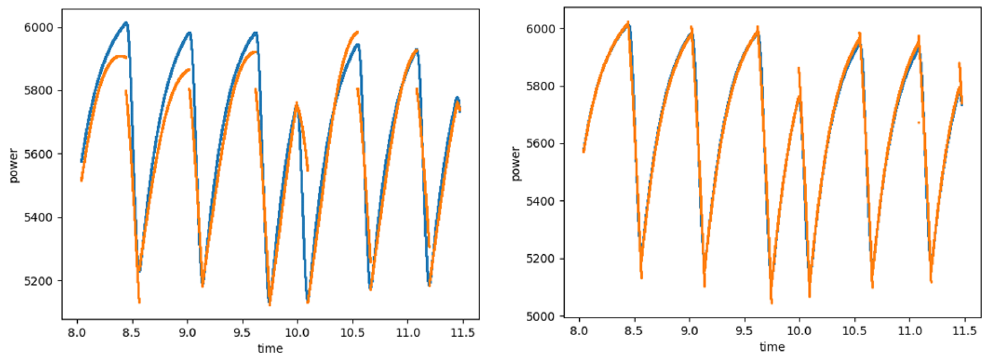
Figure 16. Comparison with Mode 1 ( left ) and Mode 2 ( right ) in two-layer networks.